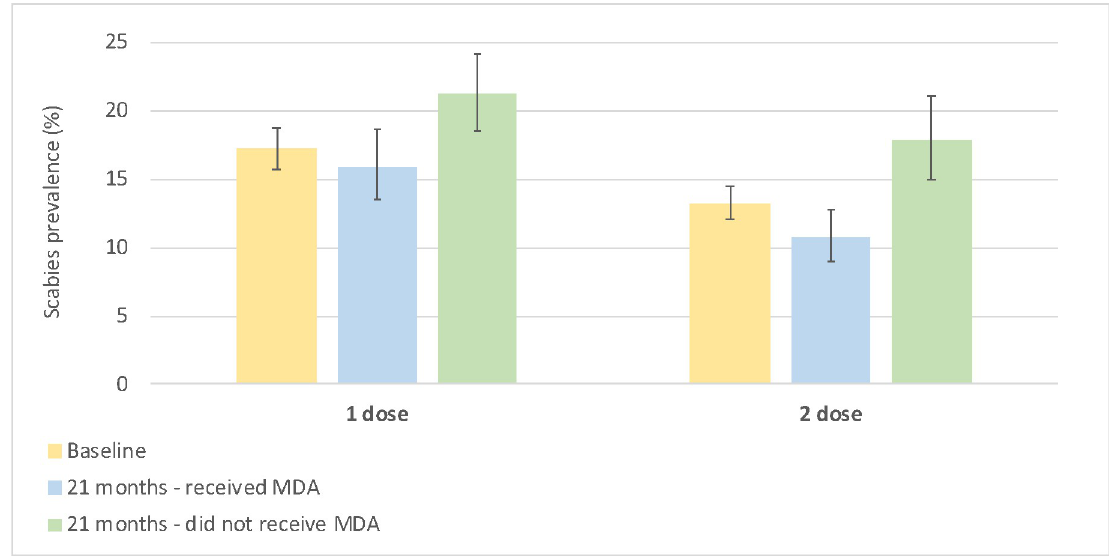
Fig 3. Scabies prevalence before mass drug administration and at 21 months in participants who did and did not receive mass drug administration (error bars indicate 95% confidence interval).